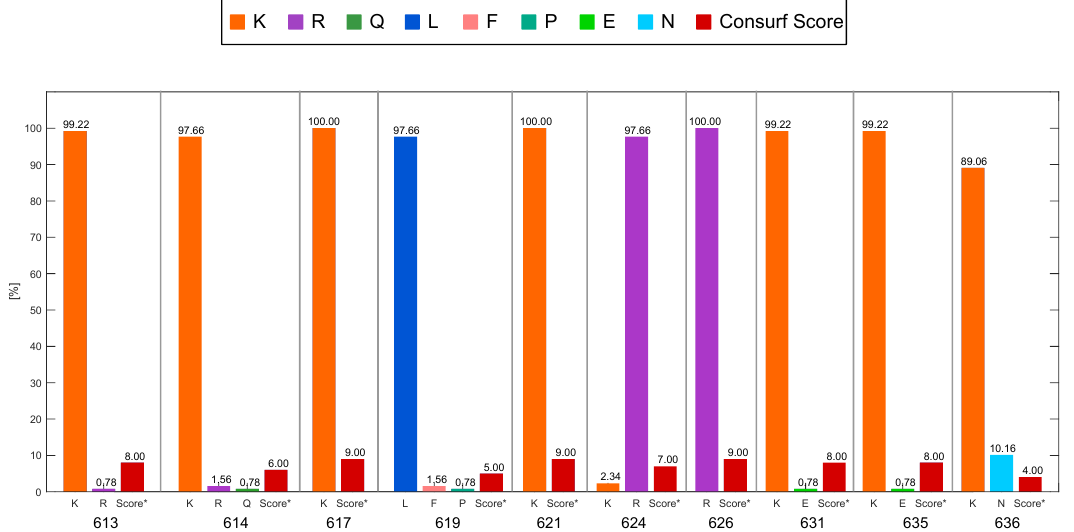
Figure 2. Percentage of Amino Acid Variation in CagA. These results were obtained from the Consurf platform. Amino acids in position 617, 621 and 626 had the highest conservation score, while the amino acid 636 had the lowest conservation score.